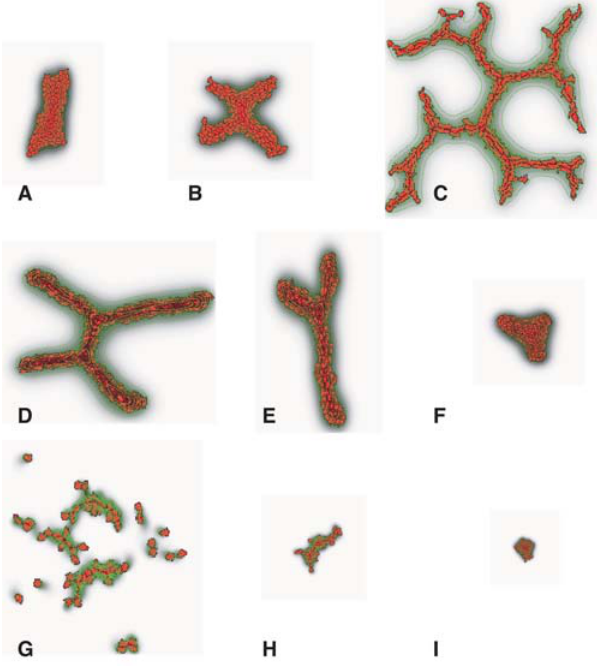
Figure 3. Sprout formation in the absence of contact inhibition. (A–C) Cell-autonomous cell elongation; (A) L =22 m m; (B) L =24 m m; (C) L =32 m m; (D–F) Adhesion-driven sprouting. (D) J ( c , c )=1; (E) J ( c , c )=5; (F) J ( c , c )=10; (G–I) Passive cell elongation at short diffusion lengths; (G) D = 1 ? 10 2 14 m 2 s 2 1 ; (H) D = 2 ? 10 2 14 m 2 s 2 1 ; (I) D =3 ? 10 2 14 m 2 s 2 1